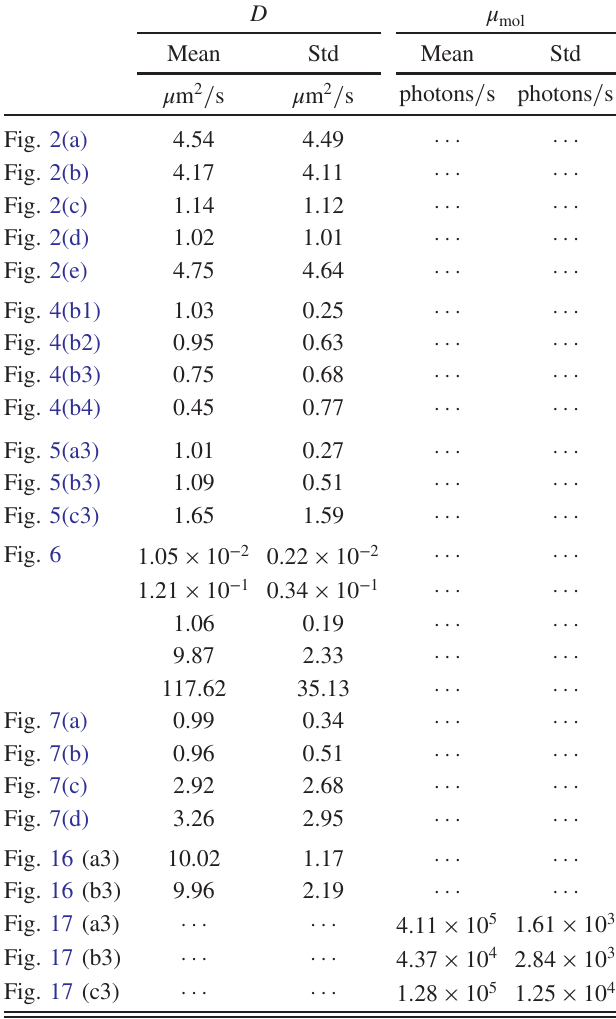
TABLE I. Here, we list point estimates of our analyses, which we obtain from the marginal posterior probability Δ t Þ . Estimates are listed distributions p ð D j Δ t Þ and p ð μ mol j according to figure.